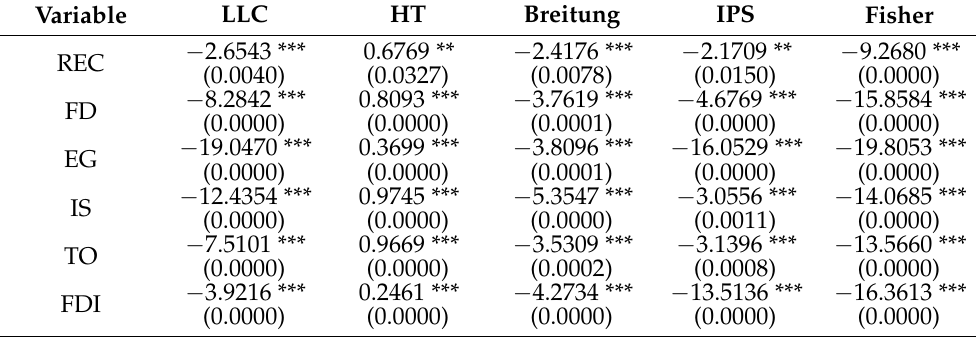
Table 3. Results of unit root tests.